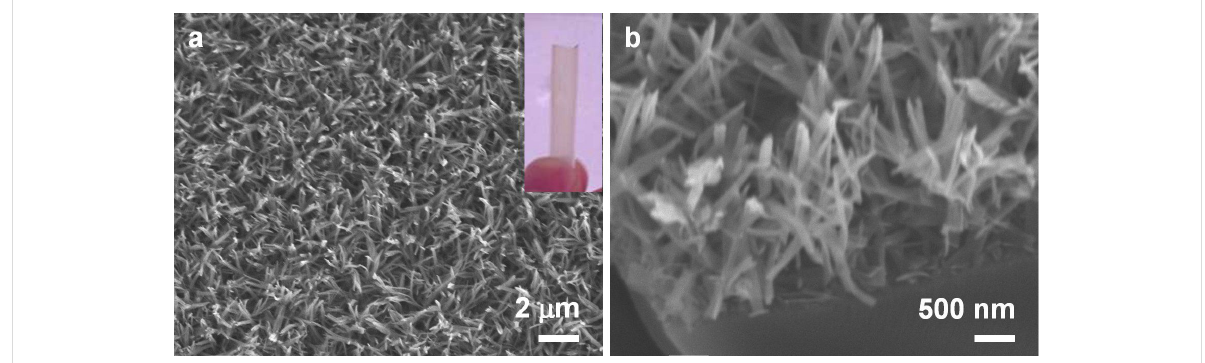
Figure 7: SEM images of LPEI@silica nanograss surface functionalized with porphyrin moieties. This functional nanograss was constructed by miner- alization of silica on a self-assembled matrix prepared from a 3.0 wt % LPEI aqueous solution containing TSPP with the molar ratio of [EI]/[TSPP] = 300/1. A mixture of 3 mL IPA, 3 mL water and 0.2 mL MS51 was used as silica source and the silicification reaction was performed at room tempera- ture for 40 min. The inset in (a) is a photograph of a tube with the functionalized nanograss, and the weak red colour indicates that the porphyrin has been successfully incorporated into the hybrid